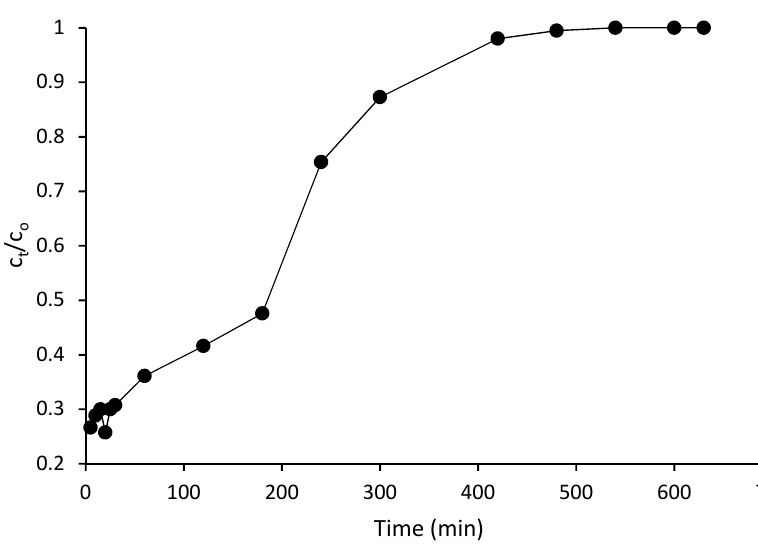
Figure 8. Breakthrough curve after regeneration of the composite.